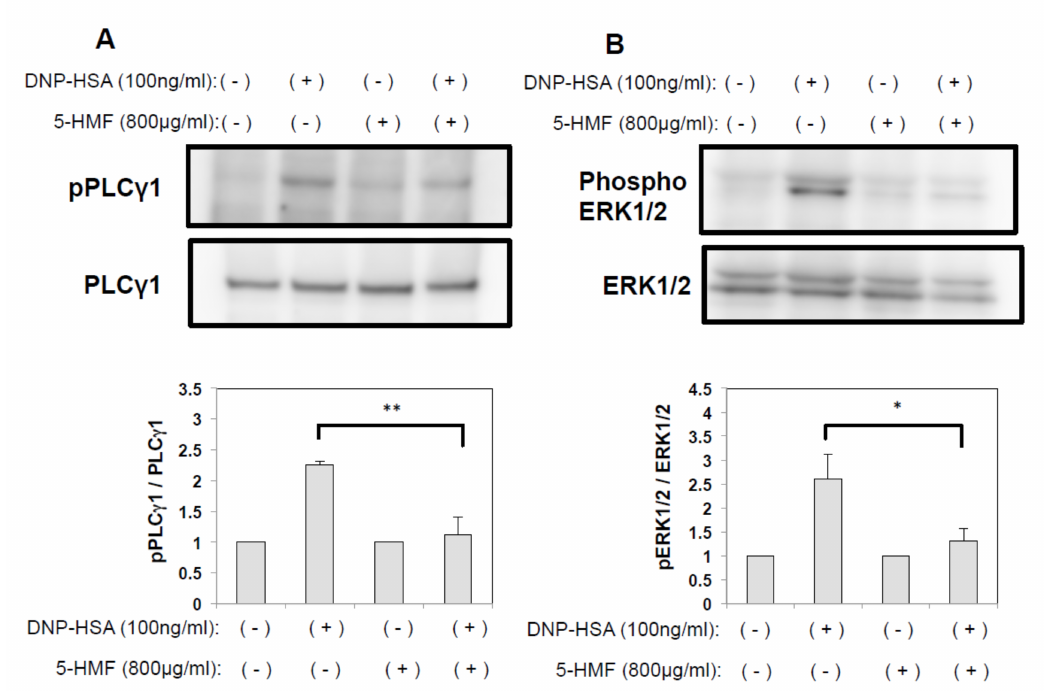
Figure 6. ( A ) Inhibition of PLC γ 1 phosphorylation in mast cells treated with 5-HMF. After stimulation with DNP-HSA, mast cells were lysed and the cytosol fraction was immunoblotted with anti-phospho-PLC γ 1 (Top). Data were normalized to the expression levels of non-phosphorylated PLC γ 1 (Bottom). ( B ) Inhibition ERK1 / 2 phosphorylation in mast cells treated with 5-HMF. After stimulation with DNP-HSA, mast cells were lysed and the cytosol fraction was immunoblotted with anti-phospho-ERK1 / 2 (Top). Data were normalized to the expression levels of non-phosphorylated ERK1 / 2 (Bottom). Data are presented as mean (SD). * p < 0.05, ** p < 0.01, two-tailed Student’s t